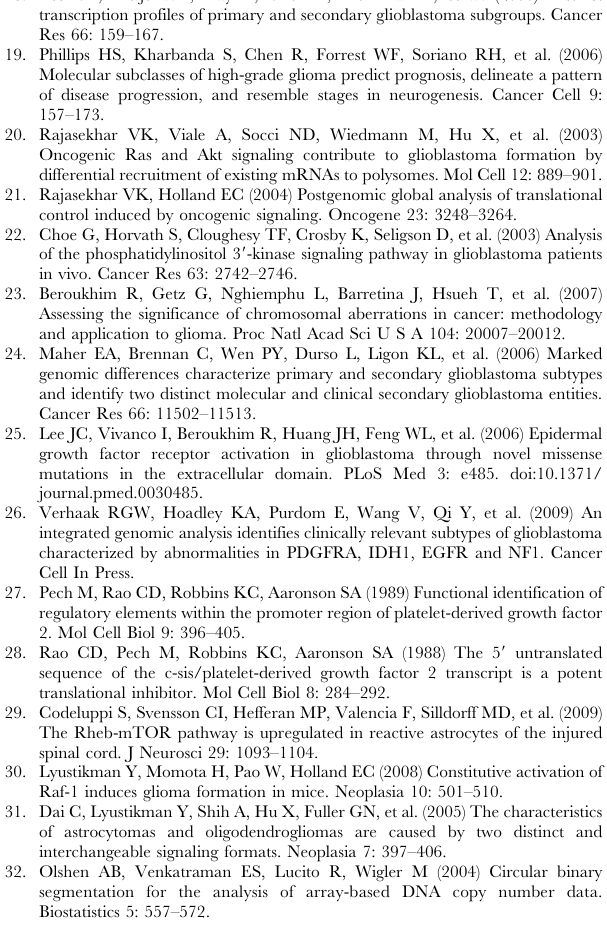
Table S2 Quantified western results. Western bands quantified by densitometry and normalized to actin (see Methods). Images of selected bands are shown in Figure S1.